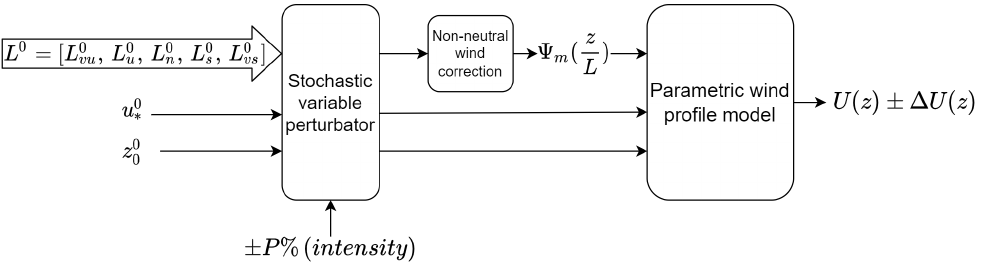
Figure 8. Sensitivity simulator block diagram. L 0 , u 0 ∗ , and z 0 denote the nominal values for L , u ∗ 0 ,and z 0 , respectively. Subscripts vu , u , n , s , and vs stand for very unstable, unstable, neutral, stable, and very stable atmospheric stability conditions, respectively. The non-neutral wind correction block implements Equation (7) and the parametric wind profile model block refers to Equation